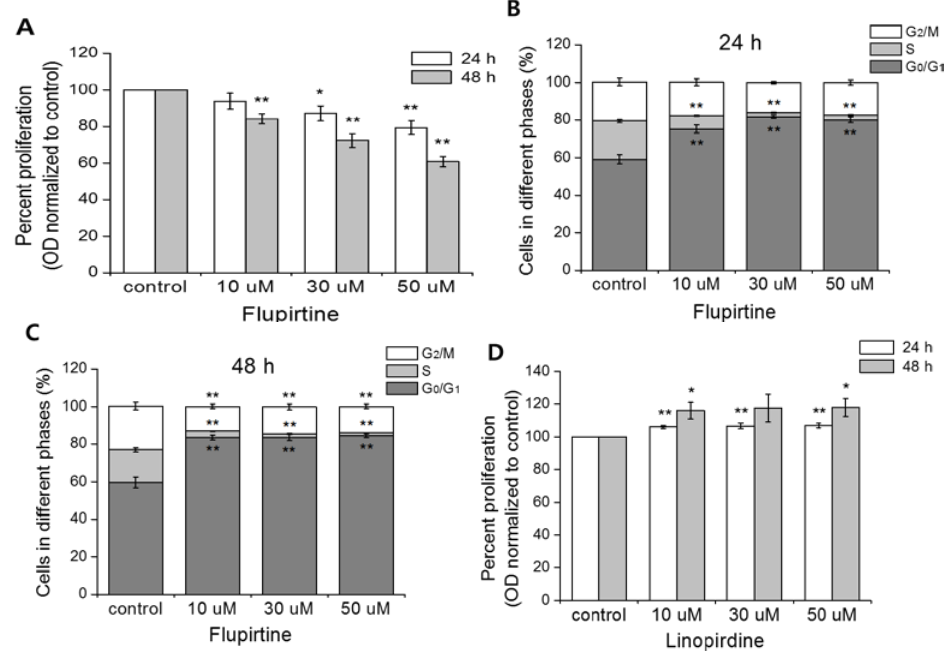
Figure 4. Changes in the cell cycle phase distribution and decreases in cell proliferation due to the Kv7 channel opener, flupirtine. ( A ) Flupirtine treatment (10, 30, and 50 µM) induced a decrease in the proliferation rate compared to the control in a concentration- and time-dependent manner. The values are the mean ± SEM of seven independent MTT assays. The asterisks denote values significantly different from each control (24 or 48 h). The treatment (with flupirtine for 24 ( B ) and 48 h ( C ) demonstrated the inhibition of the G –S transition in a concentration- and time-dependent manner. The values are the 1 mean ± SEM of four independent flow cytometry assays. The asterisks denote values /G , S, or G /M). ( D ) Linopirdine treatment significantly different from each control G 0 1 2 (10, 30, and 50 µM) increased the proliferation rate compared to the control in a time-dependent manner. The values are the mean ± SEM of eight independent MTT assays. The asterisks denote values significantly different from each control (24 or 48 h). * p < 0.05; ** p <